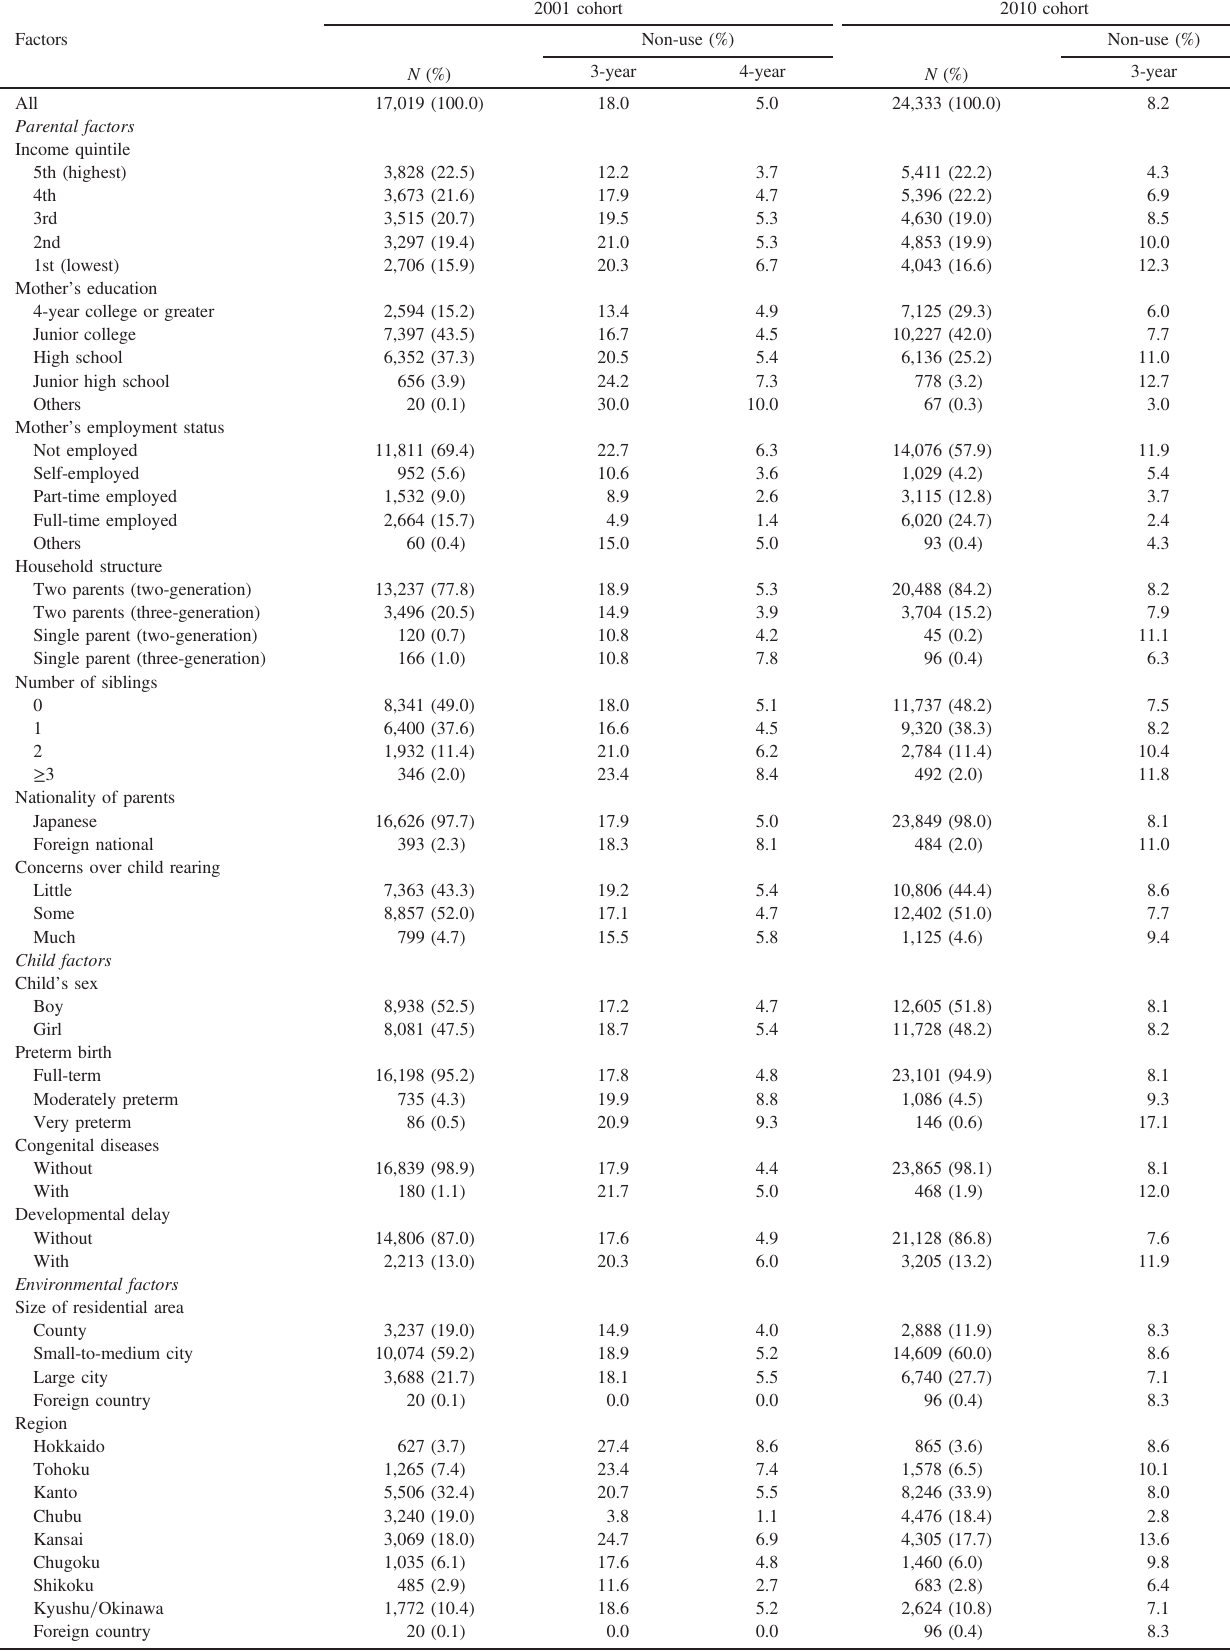
2001 cohort 2010 cohort Non-use (%) Non-use (%) N (%) N (%)